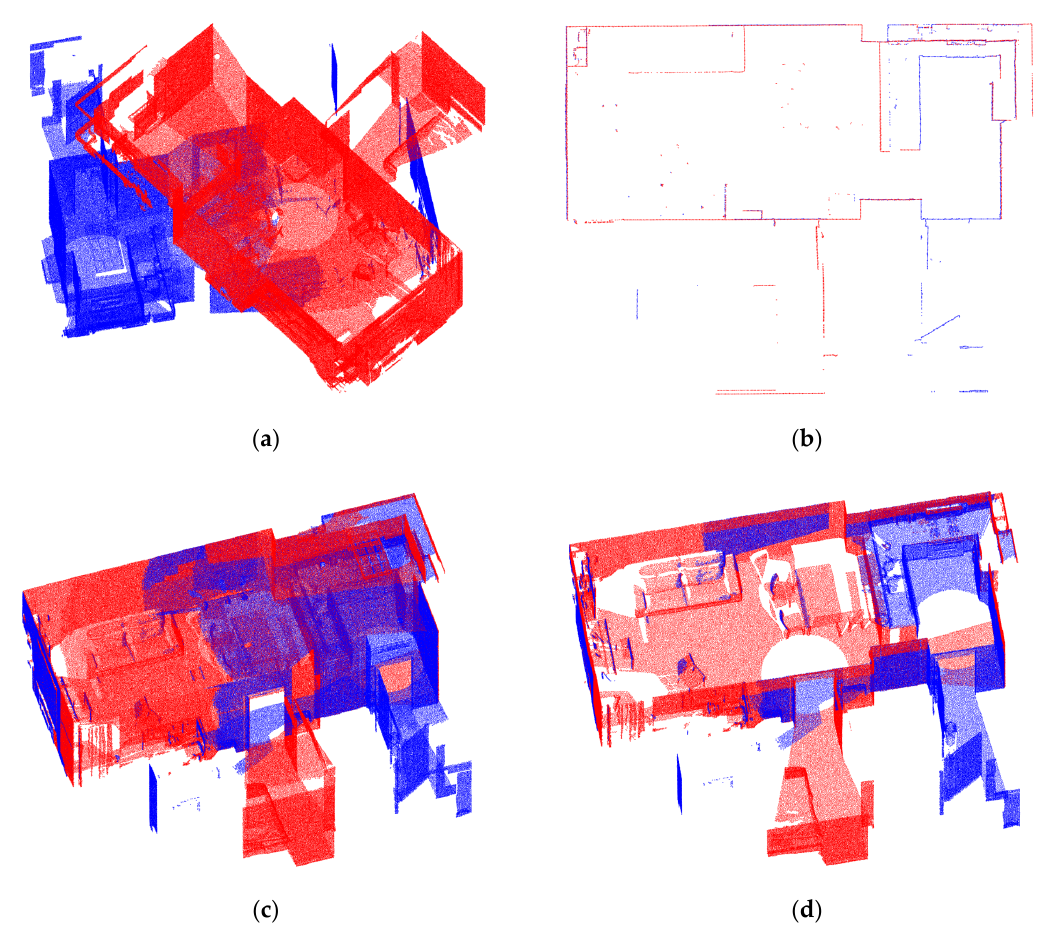
Figure 4. The coarse registration result of Apartment. ( a ) The source and target point clouds. ( b ) The registration result of the simplified 2D point clouds. ( c ) The registration result of the 3D point clouds. ( d ) The registered point clouds after removing the points on the ceiling for a better